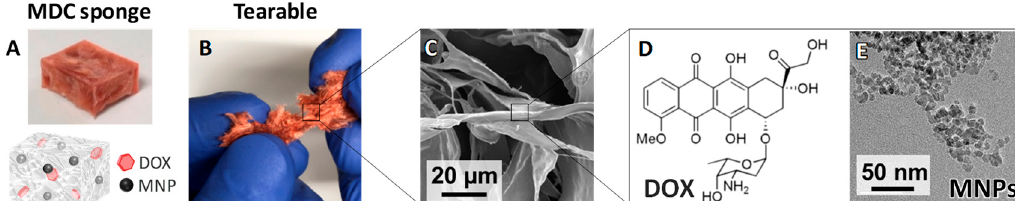
Figure 1. Characteristics of the MNPs and DOX-loaded collagen (MDC) sponges. ( A ) Photograph of the MDC sponge and illustration showing its structure. ( B ) Photograph showing that the MDC sponge is tearable. ( C ) SEM images of the MDC sponge. ( D ) Chemical structure of DOX. (E) TEM images of MNPs-8.